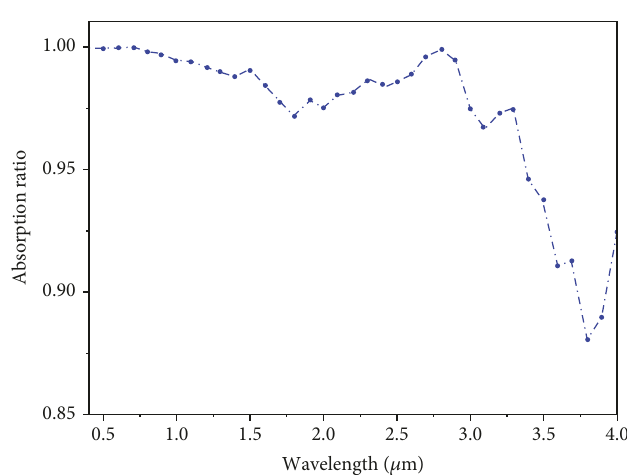
Figure 13: Absorptivity varying curve of random surface structure along with wavelength.